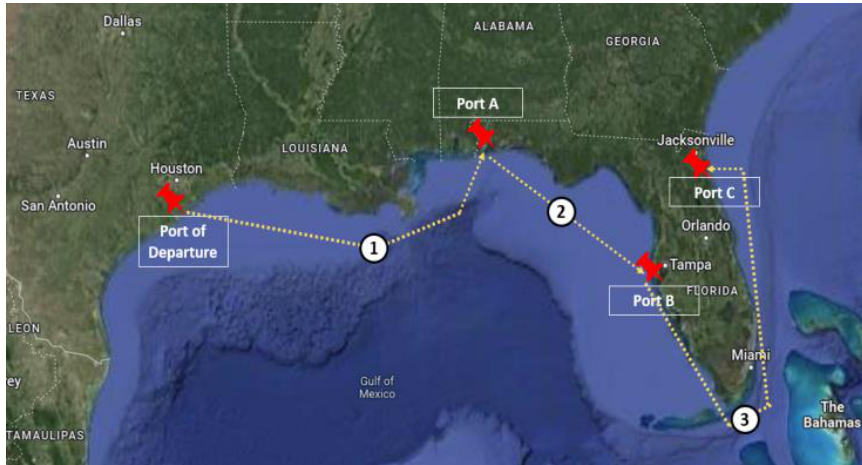
Figure 2. A representative illustration of a multi-port, multi-segment navigation and berthing problem.